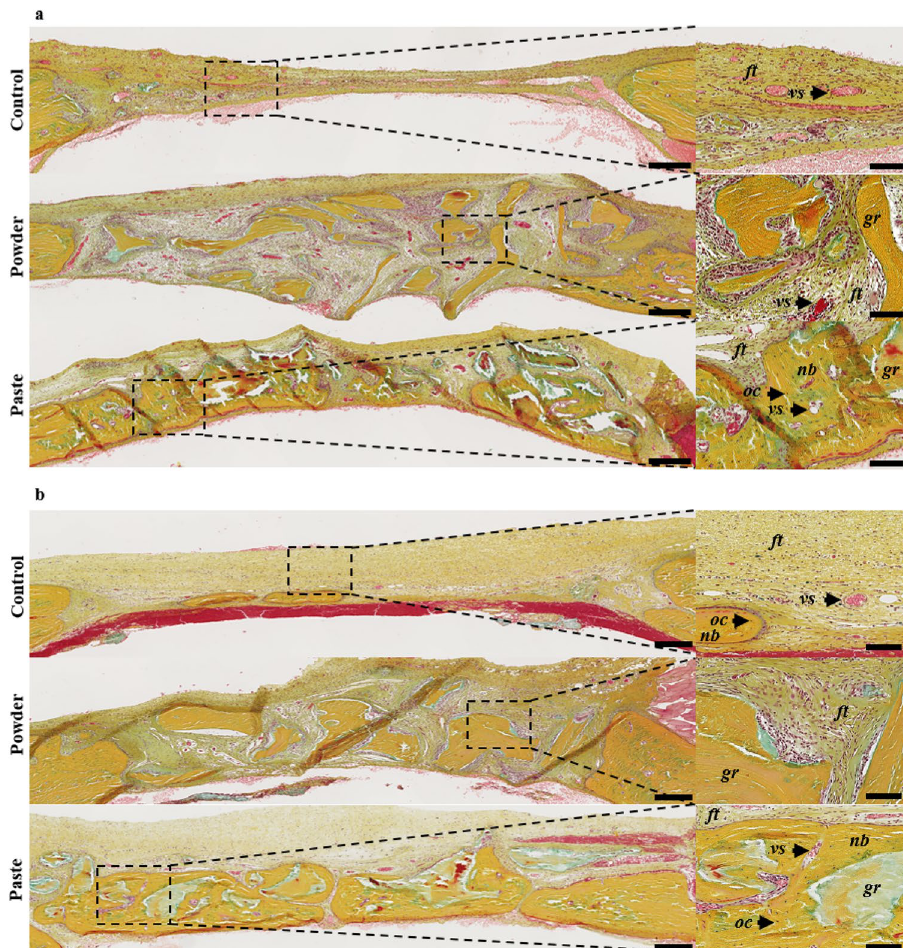
Figure 5. Rat calvaria healing at 3 and 7 weeks after surgery in a critical size defect model. Representative images of the defects with Movat’s pentachrome staining of undecalcified 7-µm thick frontal section, 3 ( a ) or 7 ( b ) weeks after the surgery. The control represents the unfilled defects. Scale bars: 250 µm for the full defects, 100 µm for the high-magnification image (dashed square). Dark yellow: collagen in the mature bone, light red: cytoplasms, dark red: osteoid borders, brown: nuclei, ft: fibrous tissue, oc : osteocytes, nb : newly formed bone, vs: blood vessels, gr :